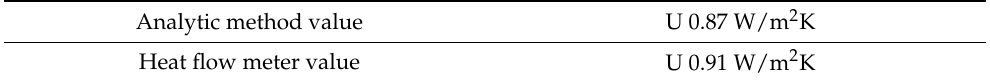
Table 9. Ante operam wall thermal transmittance.